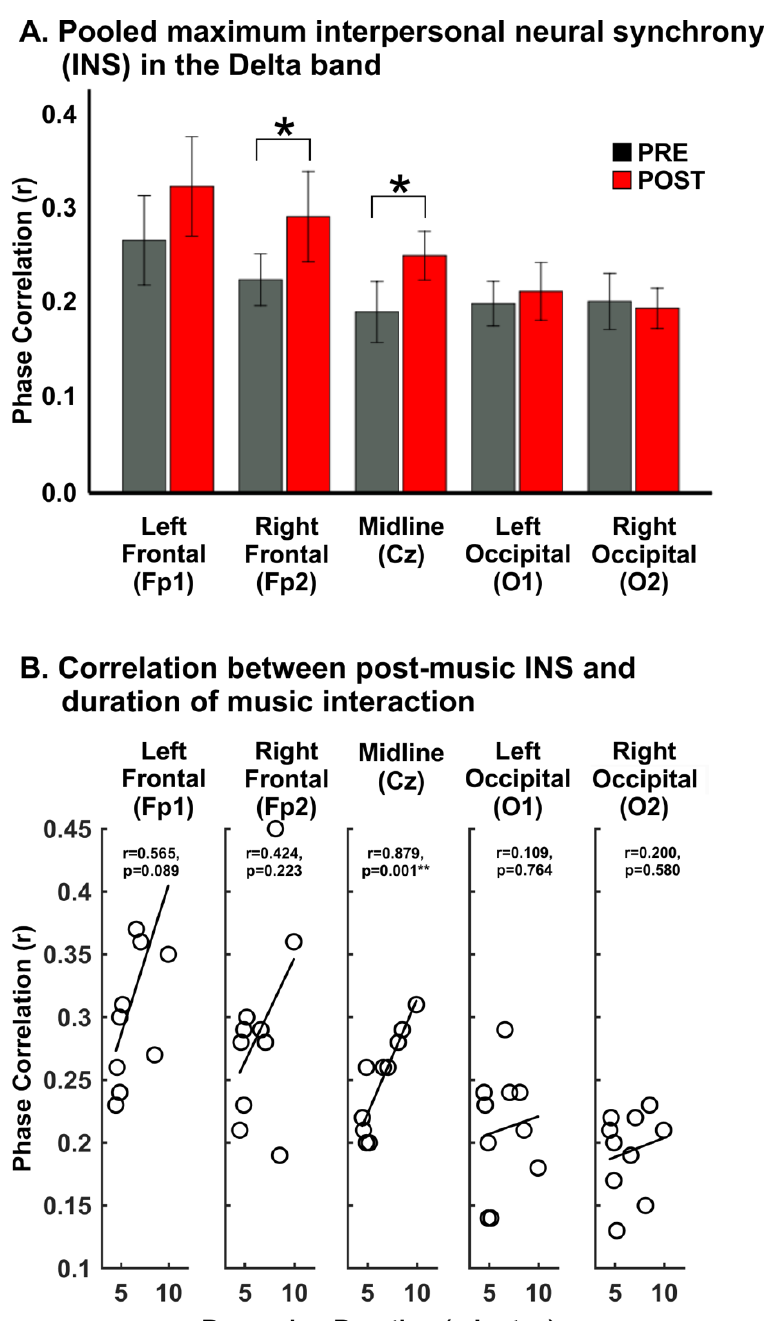
Figure 5. (A ) Bar graphs representing mean phase correlation in PRE (grey) and POST (red) conditions at each of the five electrode sites used for the study. Statistical significance is indicated by the asterisks (*). ( B ) Correlations between duration of musical interaction and POST condition delta band INS.